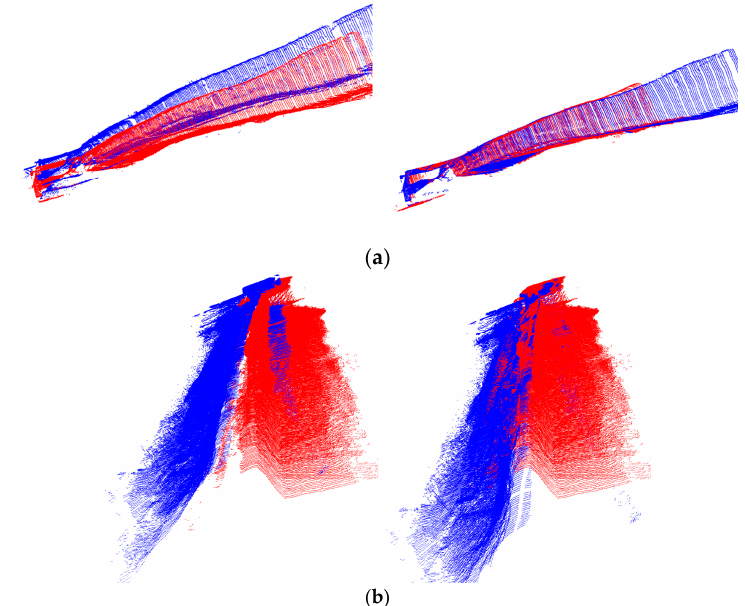
Figure 11. Optimization in flying-scan mode for a typical wall segment, ( a ) lateral view of one wall segment with two point clouds (left: before optimization; right: after); ( b ) vertical view (left: before optimization; right: after).